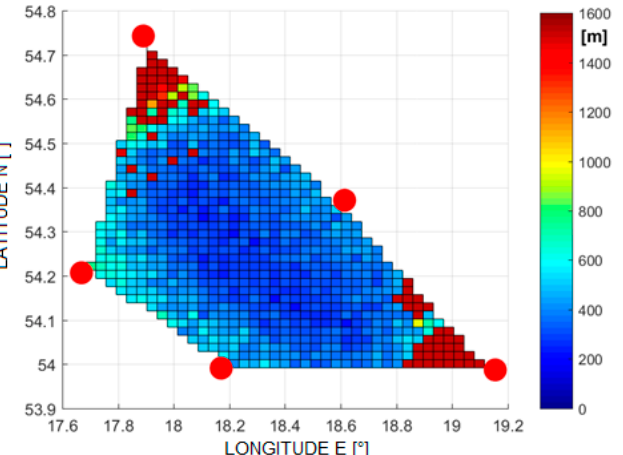
Figure 5. The RMSE of 2D position estimation in (m) for the SI algorithm (TDoA error is ±2 μ s).